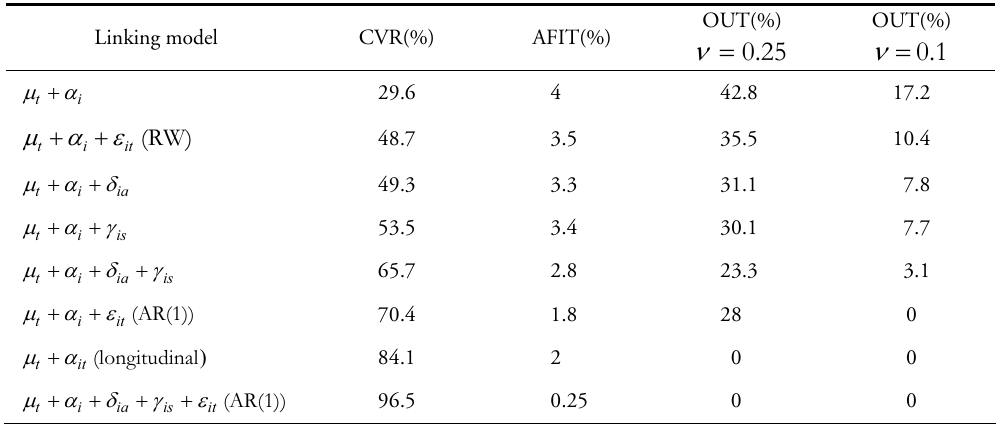
Performances of various “anova type” proposed